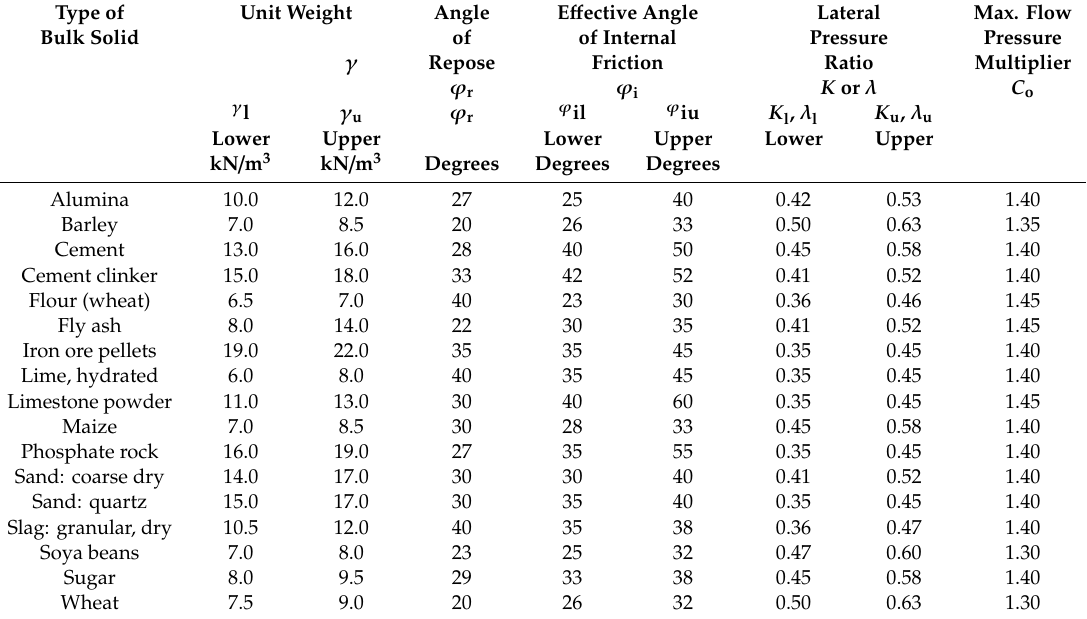
Table 7. Relationship between lateral pressure, flow, and friction, and type of bulk material